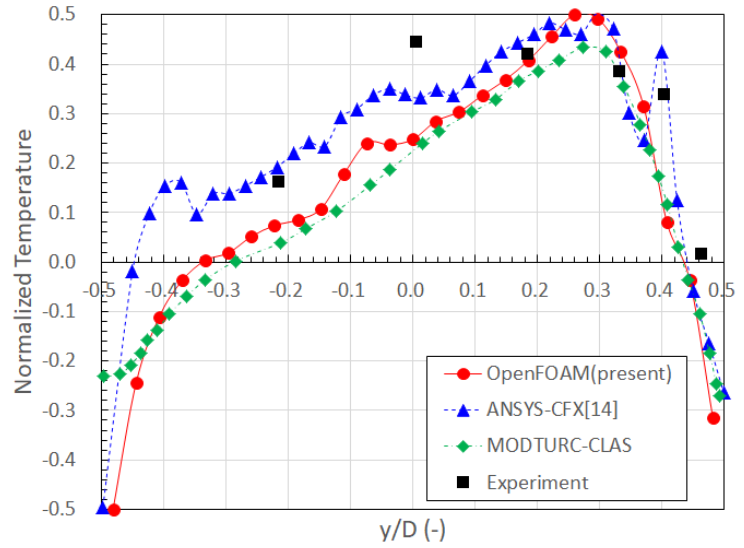
Figure 12. Validation of numerical data with other codes and experiment for the normalized temperature distribution along the vertical axis.